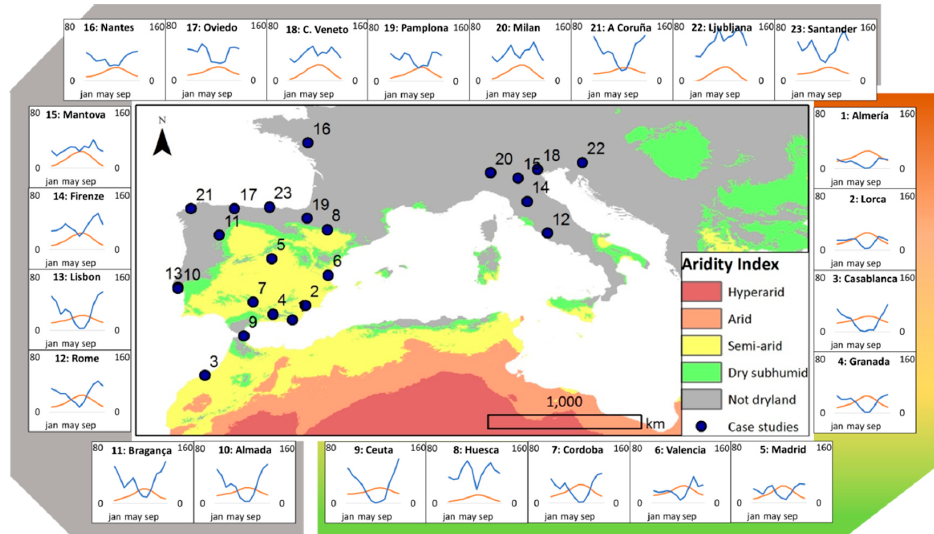
Figure 1. Map and climatic characteristics of the cities participating in this study. Left axis in climatic graphs represents monthly air temperature in °C; the right axis represents monthly precipitation in mm, and the horizontal axis represents the time in months. General characteristics of the parks (coordinates, surface area, turf area, number of trees, number of species and density of trees) are listed in SI Table S1.